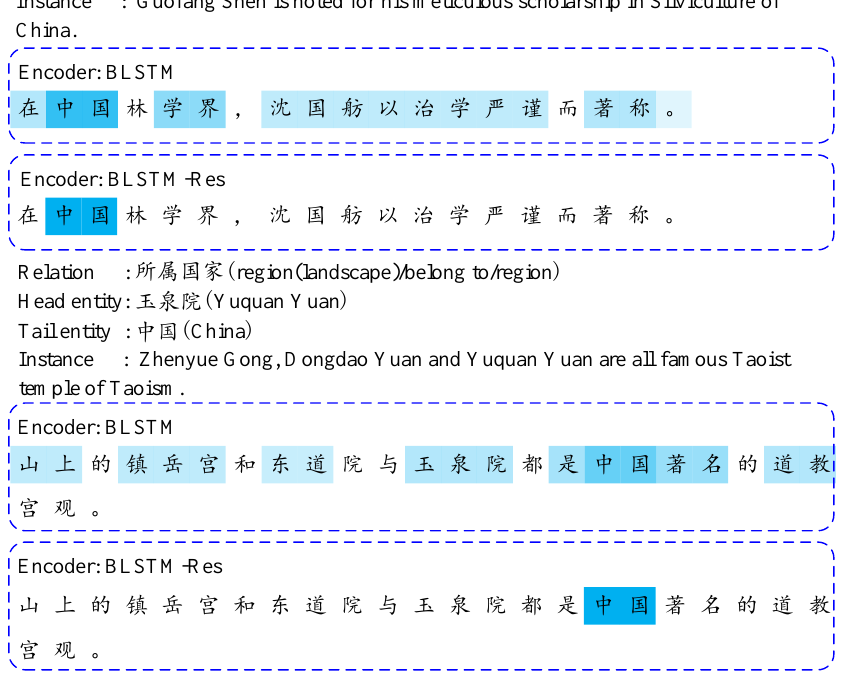
Figure 6. Attention analysis of ‘ 国 籍 ’ and ‘ 所 属 国 家 ’